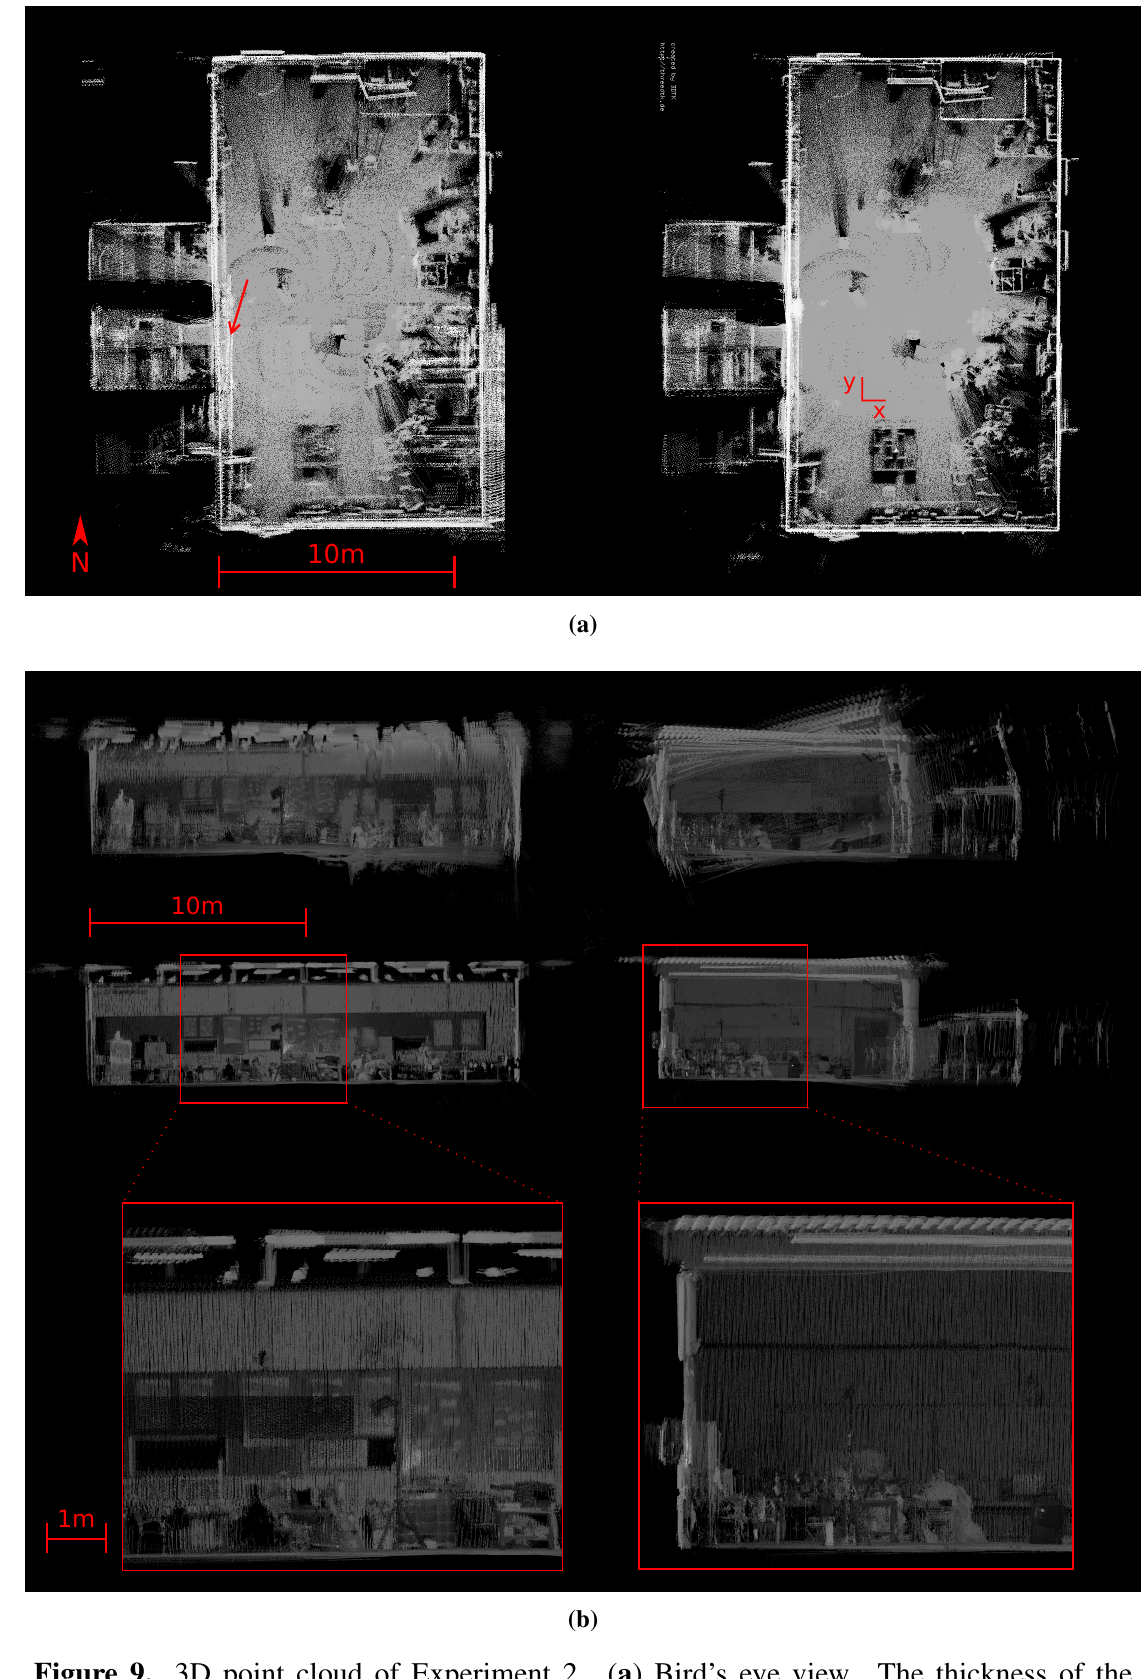
Figure 9. 3D point cloud of Experiment 2. ( a ) Bird’s eye view. The thickness of the walls decreased by optimization (red arrow). Depicted is the origin of the iSpace coordinate system. ( b ) Side views before (top) and after optimization (bottom). The scans are rotated by semi-rigid registration, such that the floor